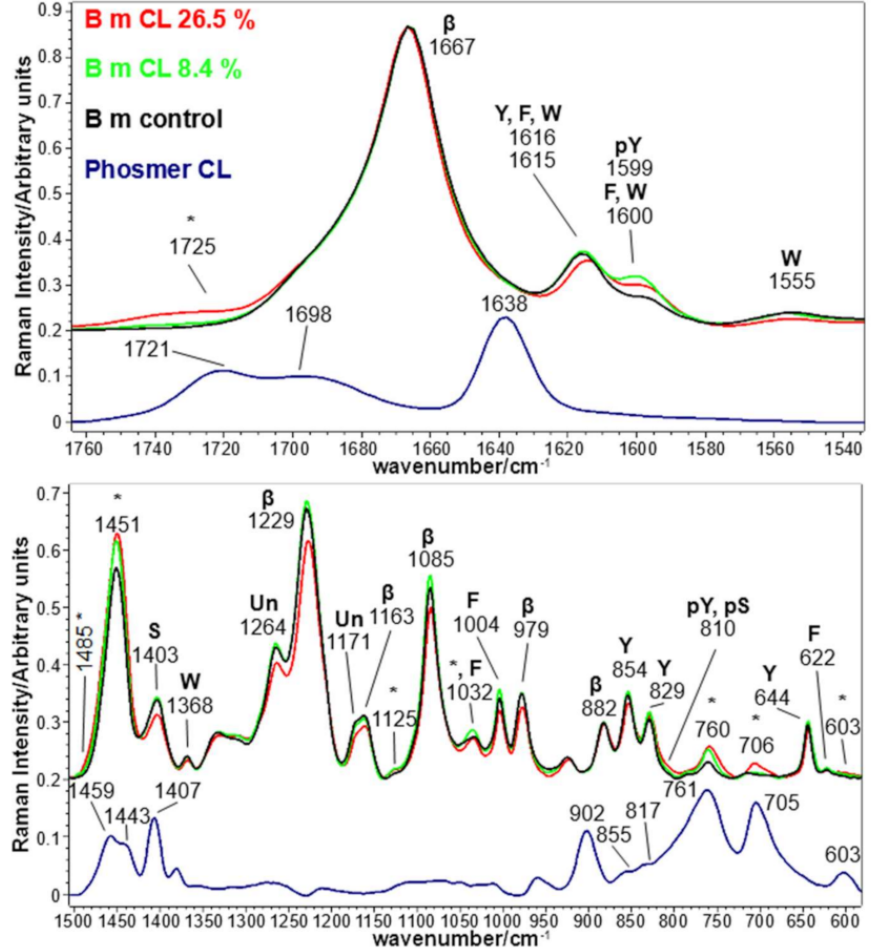
Figure 1. Raman spectra of B. mori silk fibroin fabrics before (control) and after grafting with phosmer CL (weight gains 8.4% and 26.5%). The spectra are normalized to the Amide I band (1667 cm − 1 ). The spectrum of phosmer CL is reported for comparison; the main bands that in the grafted samples strengthened due to its contribution are indicated with * (see Supplementary Material for assignments). The main bands assignable to β -sheet ( β ) or unordered (Un) conformation as well as to tyrosine (Y), phosphorylated tyrosine (pY), phenylalanine (F), serine (S), phosphorylated serine (pS) and tryptophan (W) are